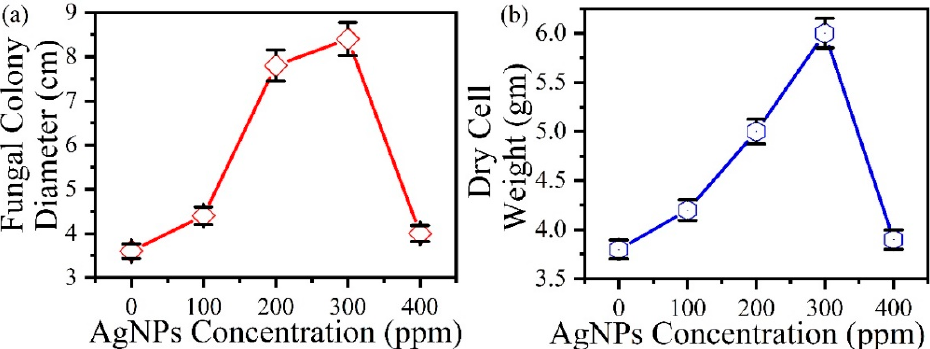
Figure 7. ( a ) The increase in fungal colony diameter with an increase in AgNPs concentration in agar media, ( b ) the increase in dry cell weight with an increase in AgNPs concentration in broth.